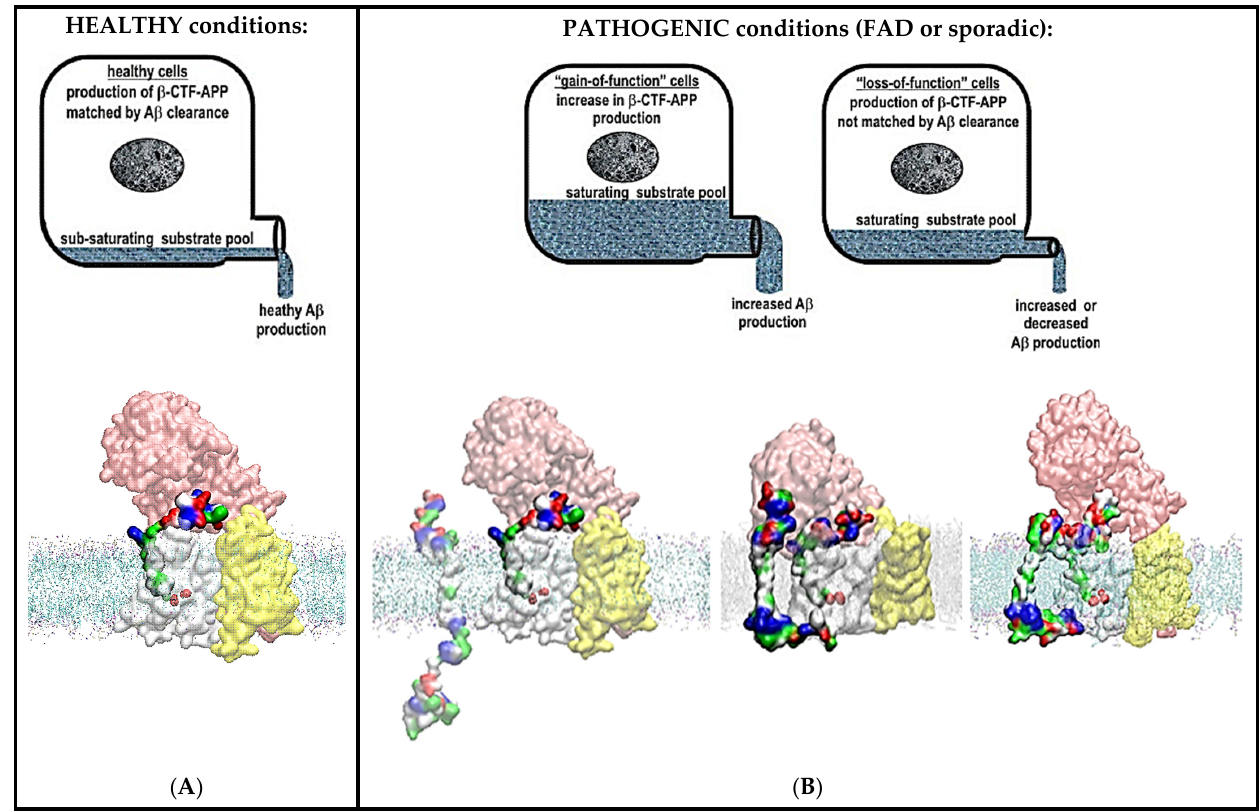
Figure 9. ( A , B ) Summary figure: decreases in catalytic capacity can trigger pathogenic changes in γ - secretase activity in sporadic and different familial cases of Alzheimer’s disease. The figure